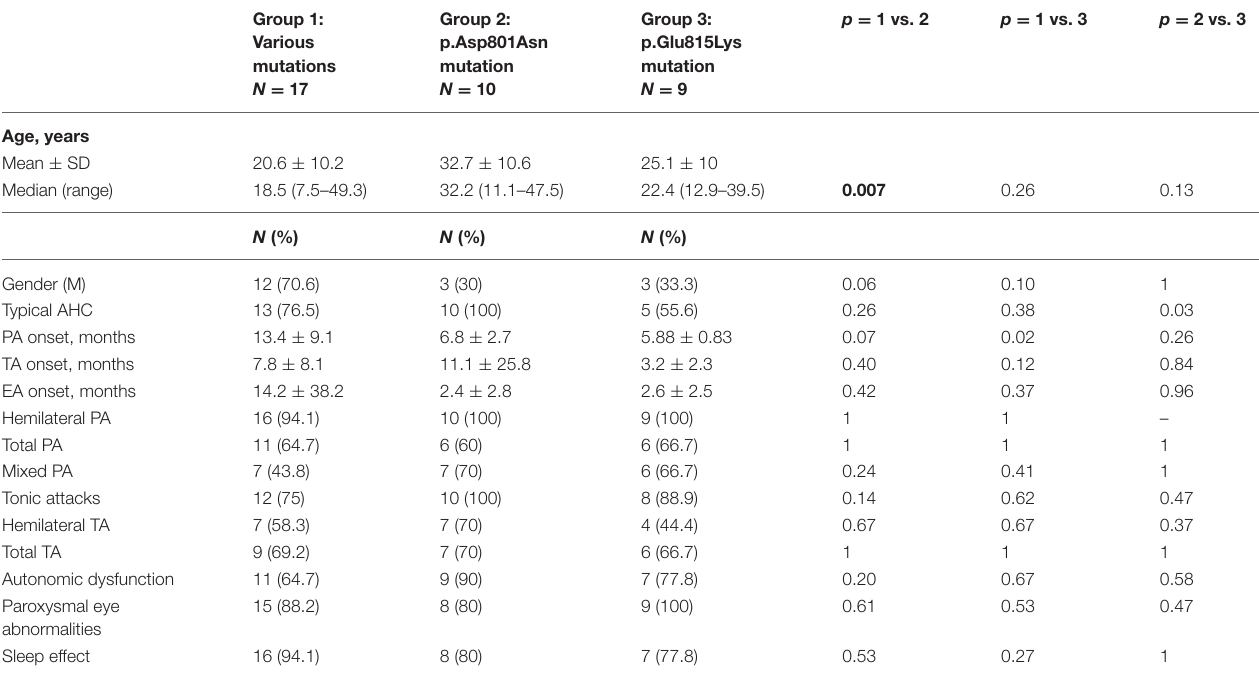
TABLE 1 | Demographic data and paroxysmal episode features in the three mutational groups.